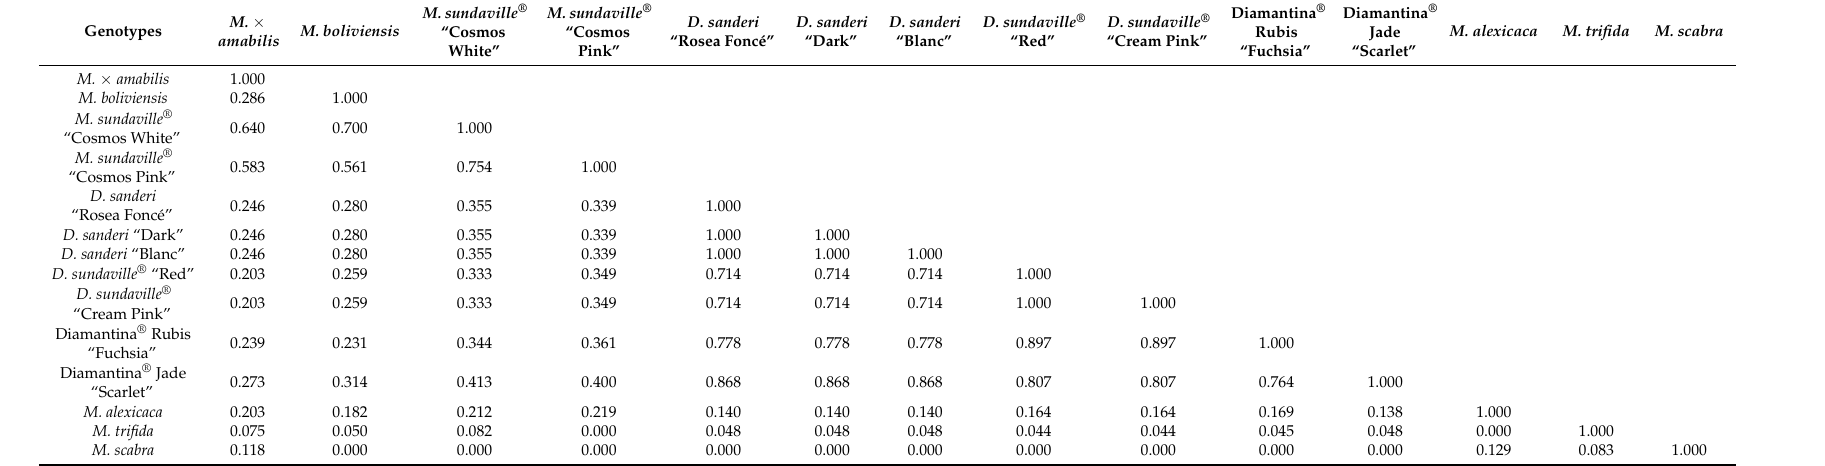
Table 3. Genotype pairwise BAND similarity coefficient based on the 20 SSRs